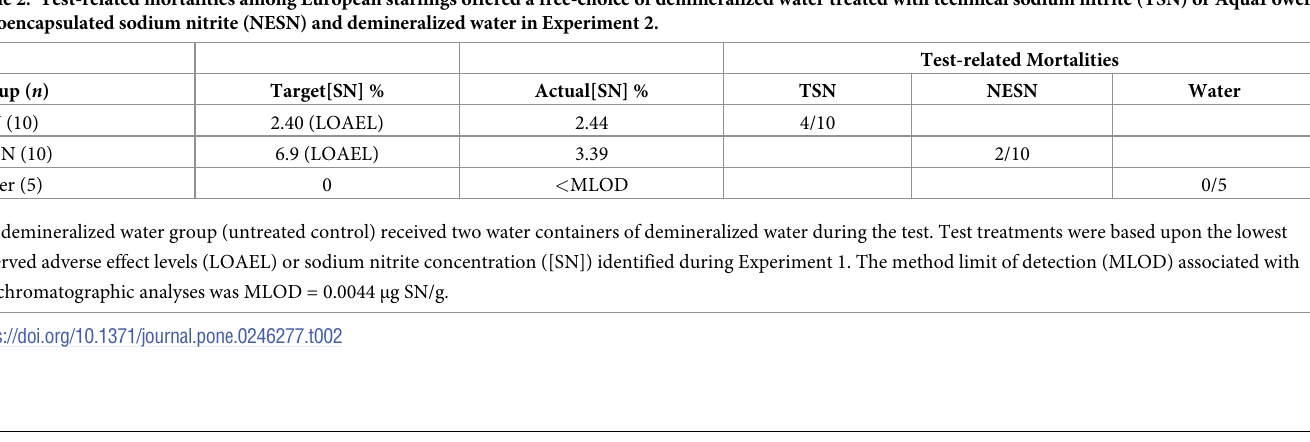
Table 2. Test-related mortalities among European starlings offered a free-choice of demineralized water treated with technical sodium nitrite (TSN) or AquaPower nanoencapsulated sodium nitrite (NESN) and demineralized water in Experiment 2. Group ( n